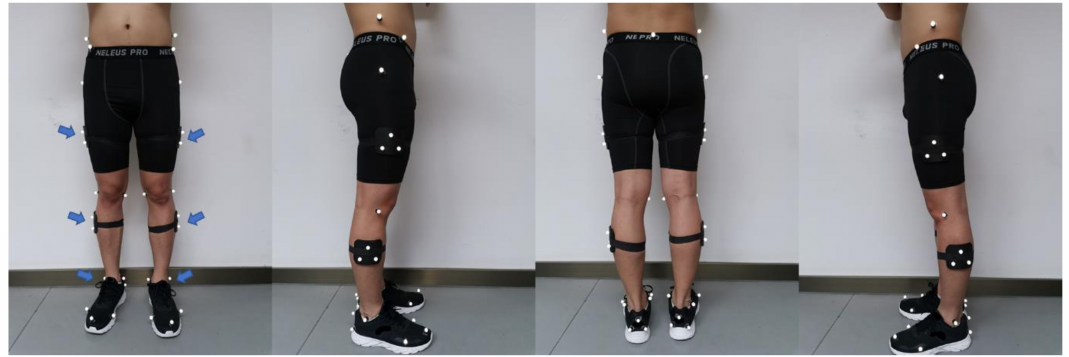
Figure 3. The placement of reflective markers and rigid